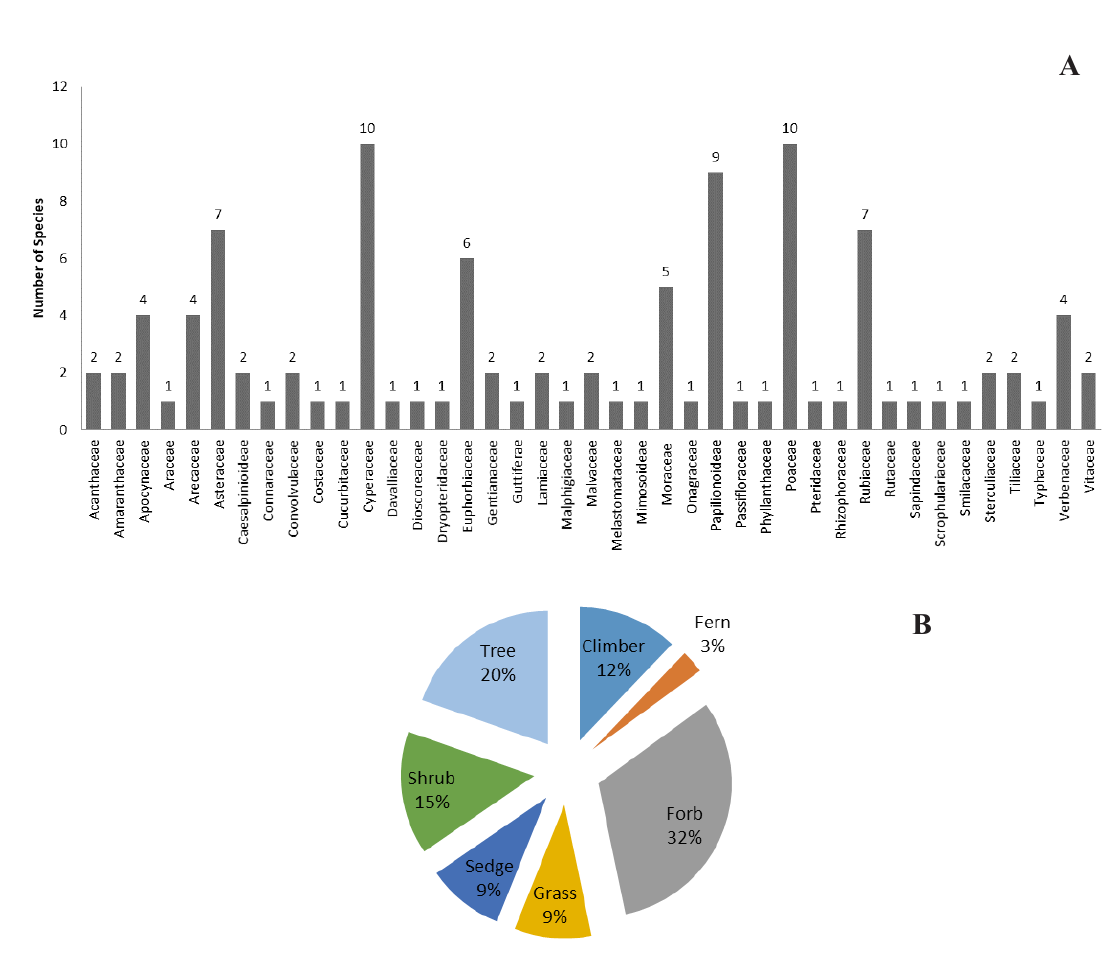
Figure 2. Distribution of species across all studied areas during the sampling